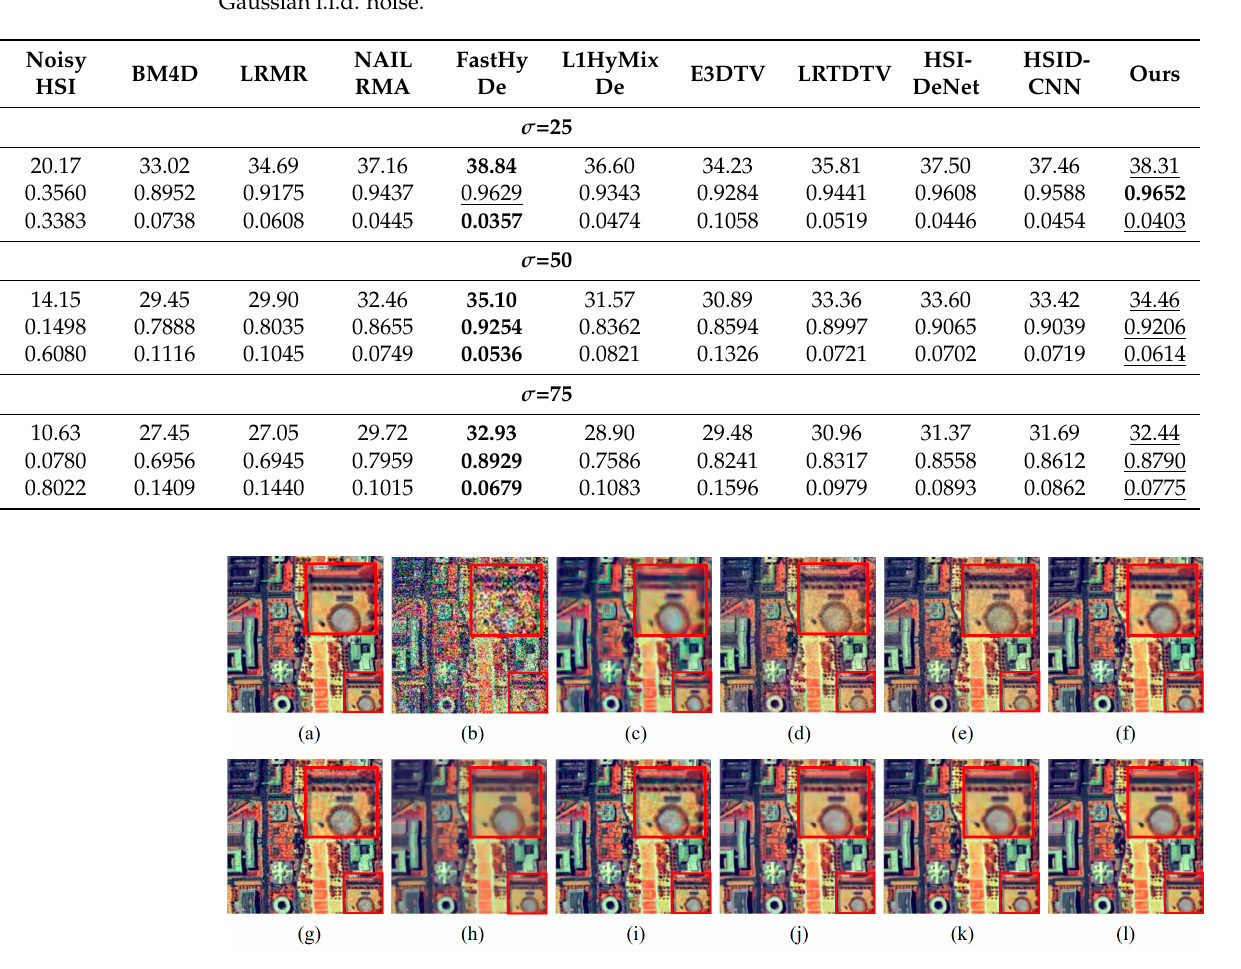
Figure 5. False color images synthesized with band 50, 70 and 112 of denoised Washington DC data in Gaussian noise case; σ = 75. ( a ) Clean; ( b ) noisy; ( c ) BM4D; ( d ) LRMR; ( e ) NAILRMA; ( f ) FastHyDe; ( g ) L1HyMixDe; ( h ) E3DTV; ( i ) LRTDTV; ( j ) HSI-DeNet; ( k ) HSID-CNN; ( l ) ours.